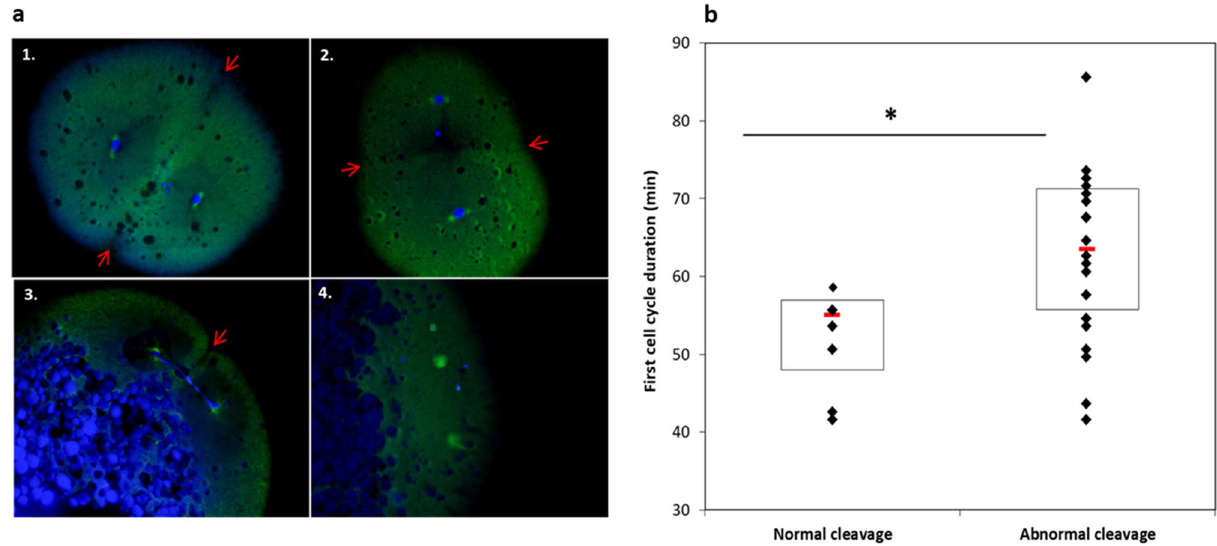
Figure 3. First-cleavage pattern after somatic cell nuclear transfer and consequence on the first cell cycle duration. ( a ) First-cleavage pattern of the clones was observed on 7 µm sections after α-tubulin immunolabelling (green) and DNA staining with HOECHST 33342 (blue). ( a1 ) Normal cleavage with two symmetric blastomeres containing a normal division spindle. ( a2–3 ) Examples of abnormal cleavage with asymmetric blastomeres and abnormal DNA / spindles pattern. ( a4 ) Absence of cleavage. ( b ) First cell cycle duration of the clones according to the cleavage pattern: Normal cleavage (n = 7 embryos) and abnormal cleavage (n = 20). Red rectangle: median; open rectangle = first + third quartile; black diamond = embryo; red arrow = cleavage grove position. * significant difference (p < 0.05).